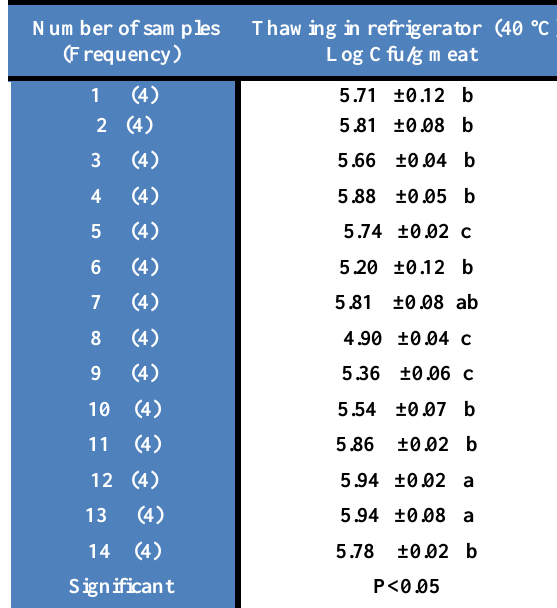
Table, 2: The mean values of total bacterial count in minced meat samples after thawing at refrigeration temp. 4C°.